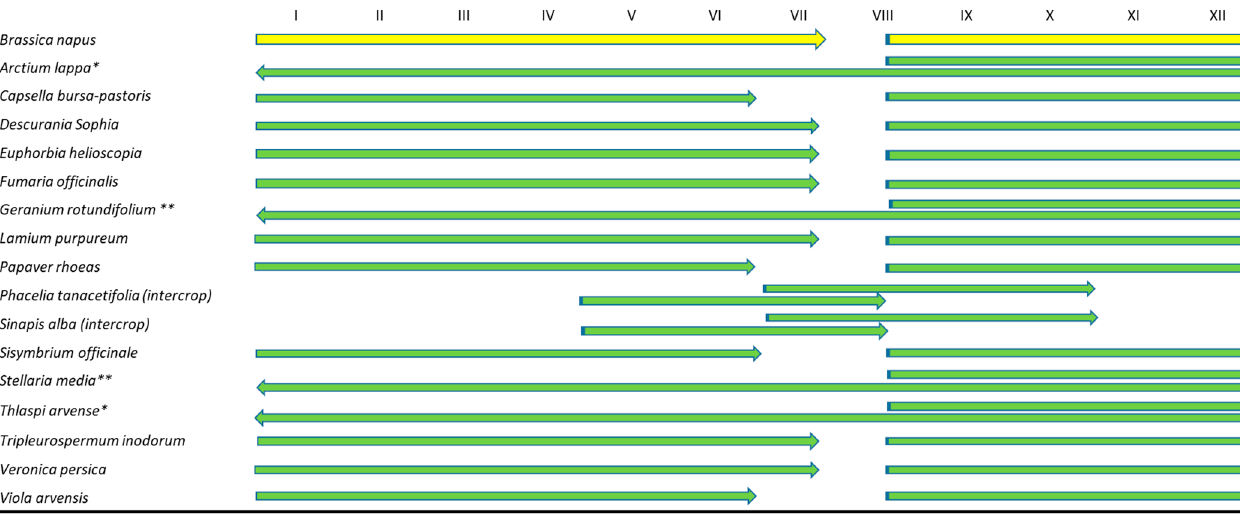
Figure 1. The growing season of oilseed rape and weeds covers the whole year. Most species are annual weeds, with the exception of A. lappa, T. arvense (* either annual or bi-annual) and S. media , G. rotundifolium (** either annual or perennial). (The blue color indicates the beginning of the growing season).